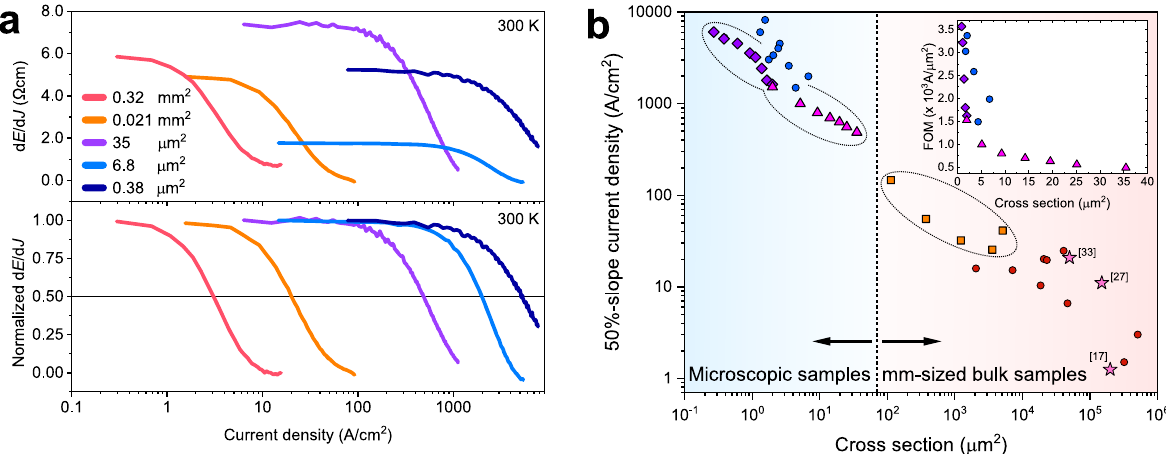
Fig. 2 Size dependence of nonlinear conduction. The top panel of a shows the differential resistivity d E /d J as a function of current density of a few selected samples at room temperature. The legend shows the cross-sectional area of these samples. For all microscopic and mm-sized bulk samples the low current resistivity at room temperature is found to be corresponding to the literature values. In the lower panel of a , the differential resistivity of these samples is normalized with respect to the low current resistivity (i.e., where the resistivity is current independent). Even though the E ( J )-characteristics of all samples are qualitatively the same, the current density scale at which they exhibit nonlinear conduction differs orders of magnitude. The current density at which the slope of the E ( J )-characteristic is halved, is chosen as the Figure of Merit (FOM), which corresponds to the horizontal reference line. b Shows the FOM as a function of cross-sectional area for all measured samples at room temperature on a log-log scale. N.B. each circular point corresponds to a single sample. The thinning study samples are depicted with a unique non-circular symbol and a different color. The inset displays the FOM vs sample cross section for selected samples on linear scales. The star symbols correspond to the FOM extracted from literature; the label indicates the reference